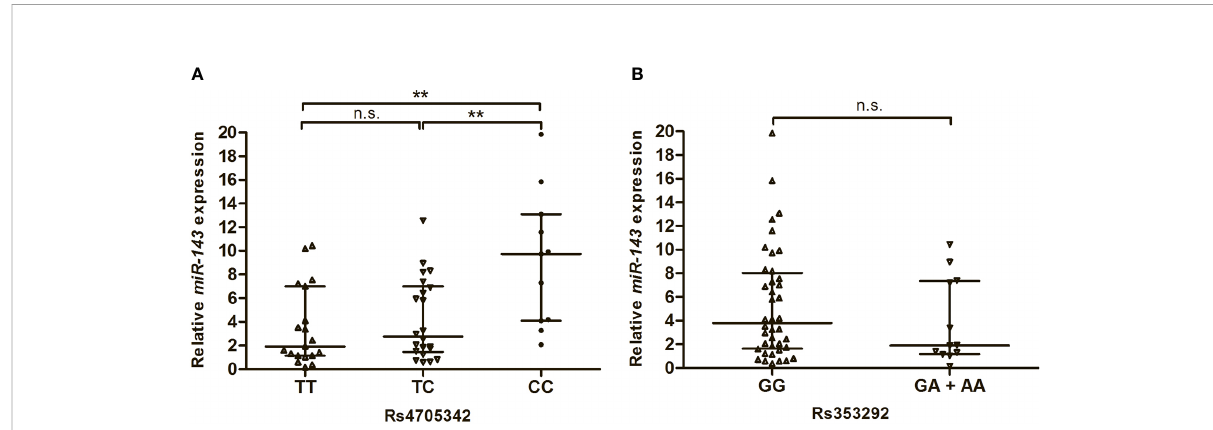
FIGURE 2 Impact of miR-143 polymorphisms on the miR-143 expression in the serum of Type 2 diabetes mellitus patients. Data were expressed as median with interquatile range, and analysed by Mann-Whitney U-test. (A) Relative expression levels of miR-143 in the serum from patients carrying the different genotypes of rs4705342. (B) Relative expression levels of miR-143 in the serum from patients carrying the different genotypes of rs353292. ** P < 0.01. n.s., not signi fi cant.